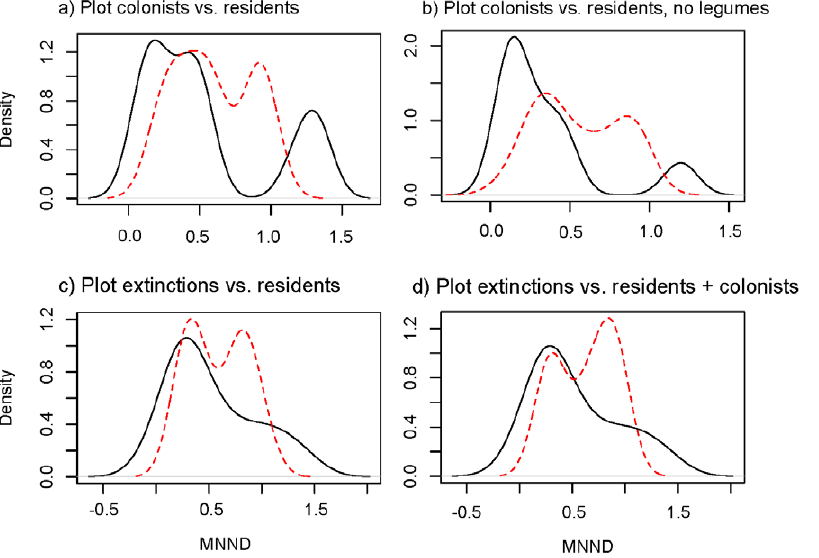
Figure 4. Density distributions of observed (solid line) and null (dashed line) MNND values between colonists and residents within communities (a, b) and between extinct species and residents (c, d).